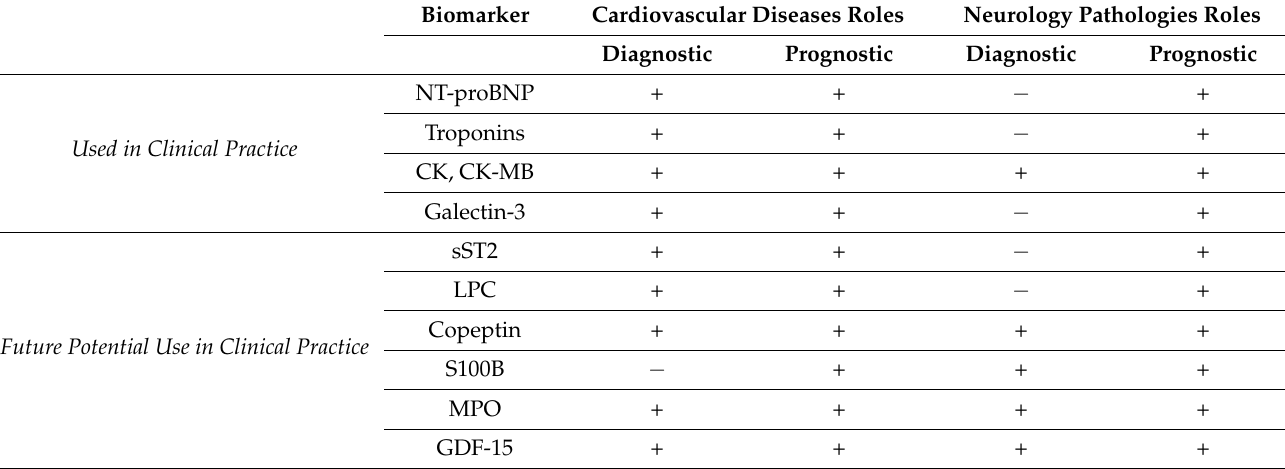
Table 1. Potential role of biomarkers in cardiovascular and neurological pathologies. Biomarker Cardiovascular Diseases Roles Neurology Pathologies Roles